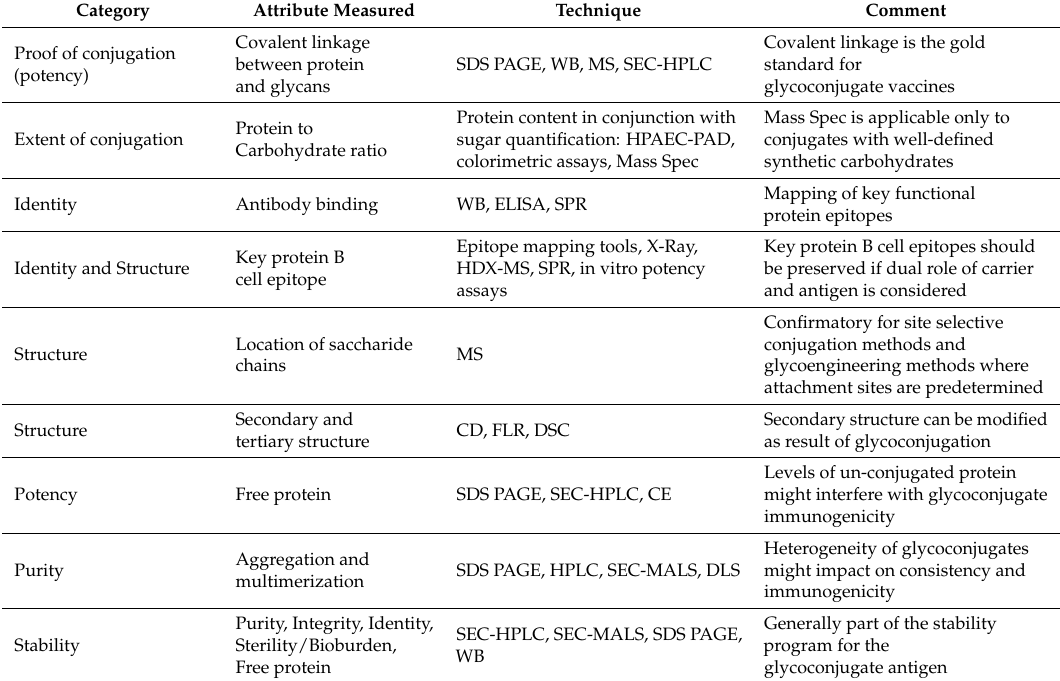
Table 3. Example of characterization panel for the protein moiety of glycoconjugate vaccines (drug